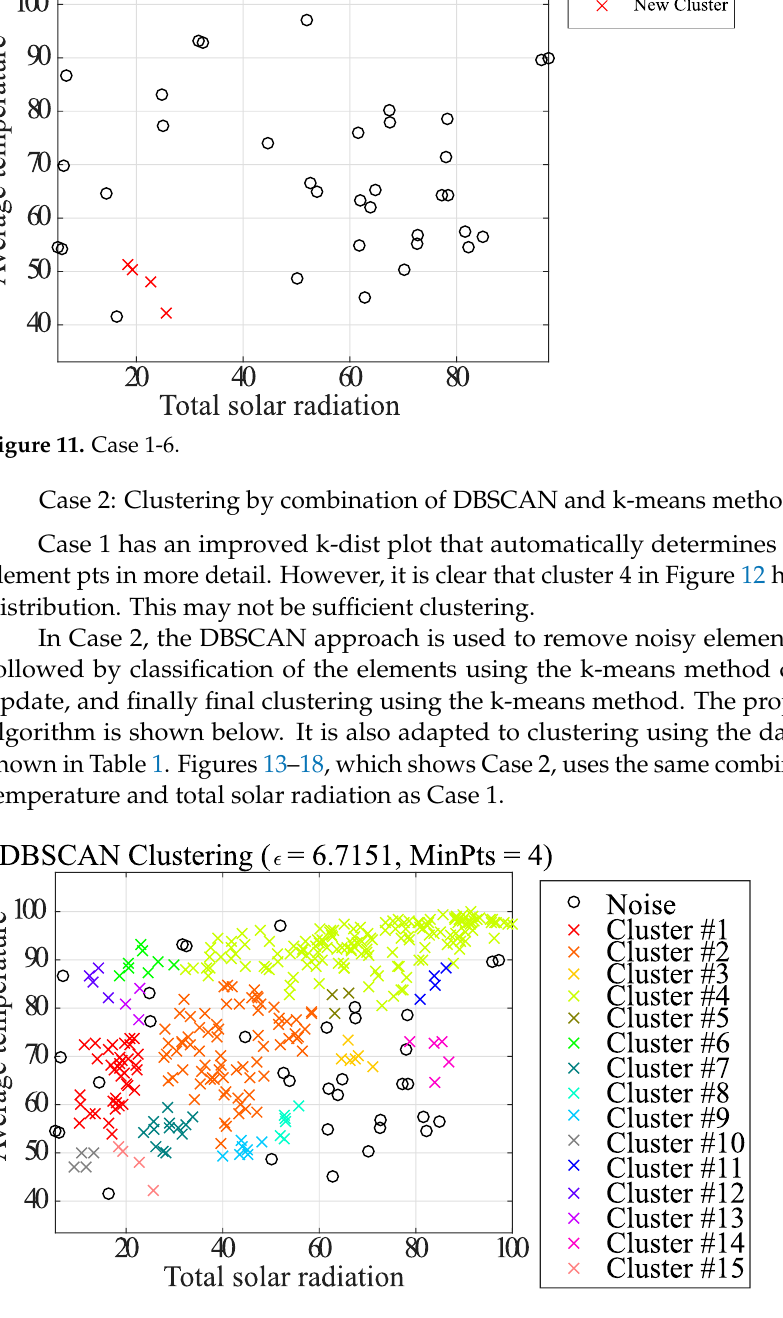
Figure 12. DBSCAN results (after